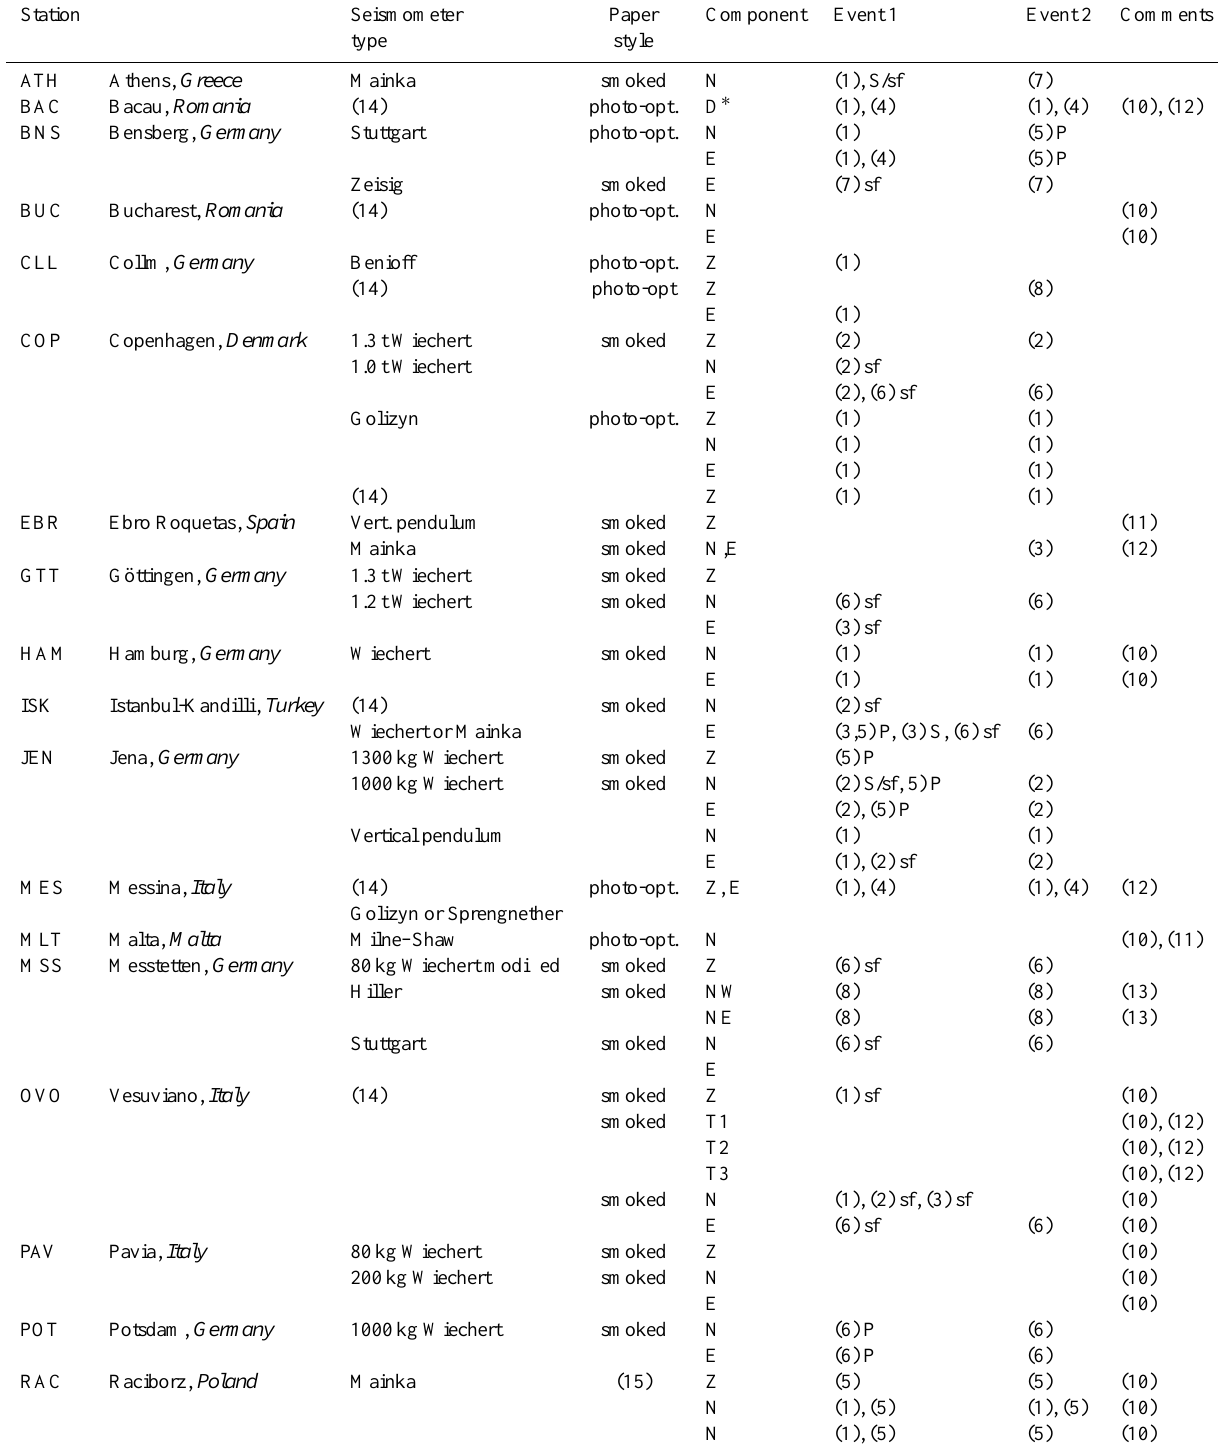
Table 3. Recording device, paper style, available component and reasons why records of the twin Amorgos earthquakes were of limited use.